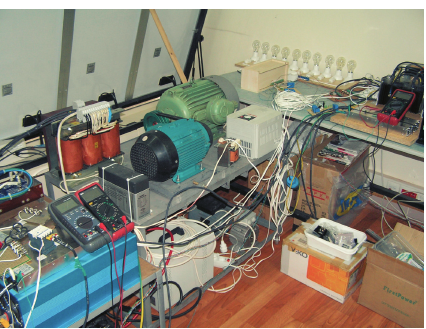
Figure 11: FLR inputs.